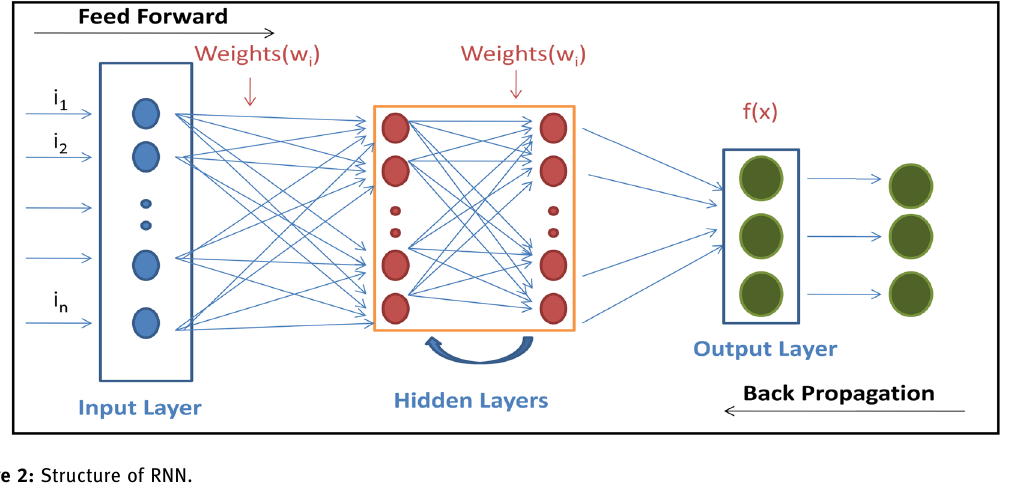
Figure 2: Structure of